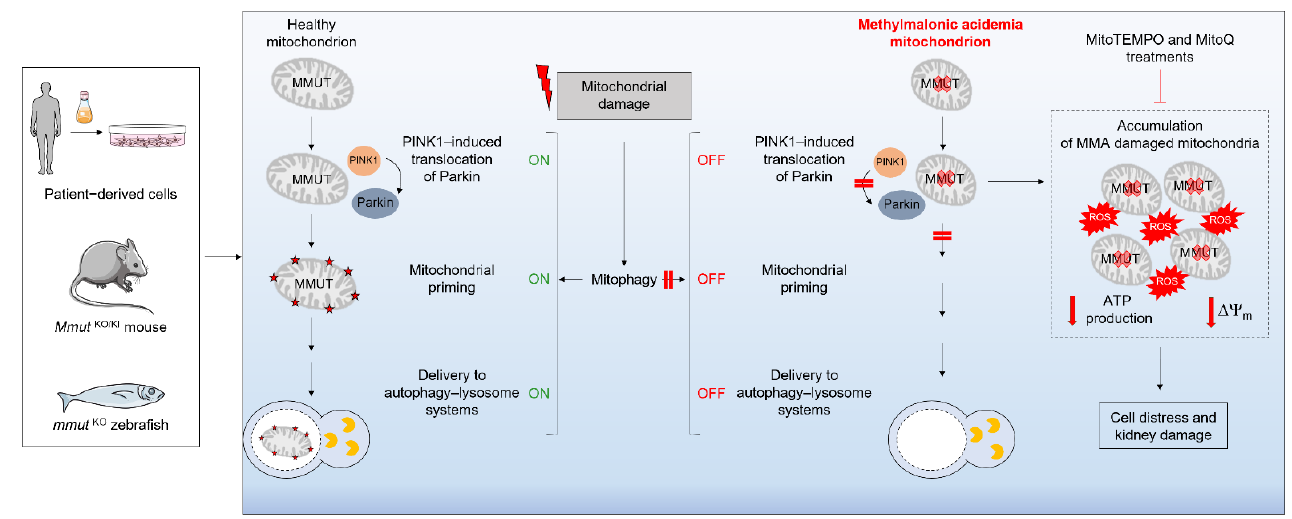
Figure 2. Working model depicting the link between MMUT, mitochondria, mitophagy, and epithelial homeostasis in healthy and MMA-affected kidney cells. In MMA-affected kidney cells and zebrafish, the deficiency of the enzyme MMUT and the resulting accumulation of toxic organic acids trigger mitochondrial abnormalities, which are characterized by a collapse of the mitochondrial membrane potential ( ΔΨ m, red arrows), impaired ATP production/bioenergetics (red arrows) and augmented generation of mitochondrial ROS and oxidative stress. Faulty execution of PINK1-Parkin-mediated mitophagy induced by MMUT deficiency impedes the delivery of damaged mitochondria and their dismantling by autophagy – lysosome degradation systems. This, in turn, promotes the accumulation of damaged and/or dysfunctional, ROS-overproducing mitochondria that, ultimately, trigger cellular and kidney damage. The treatments with mitochondria-targeted ROS scavengers mito-TEMPO or MitoQ repair mitochondrial dysfunctions, neutralizes epithelial damage in MMA cells, and improves disease-relevant phenotypes in mmut -deficient zebrafish.